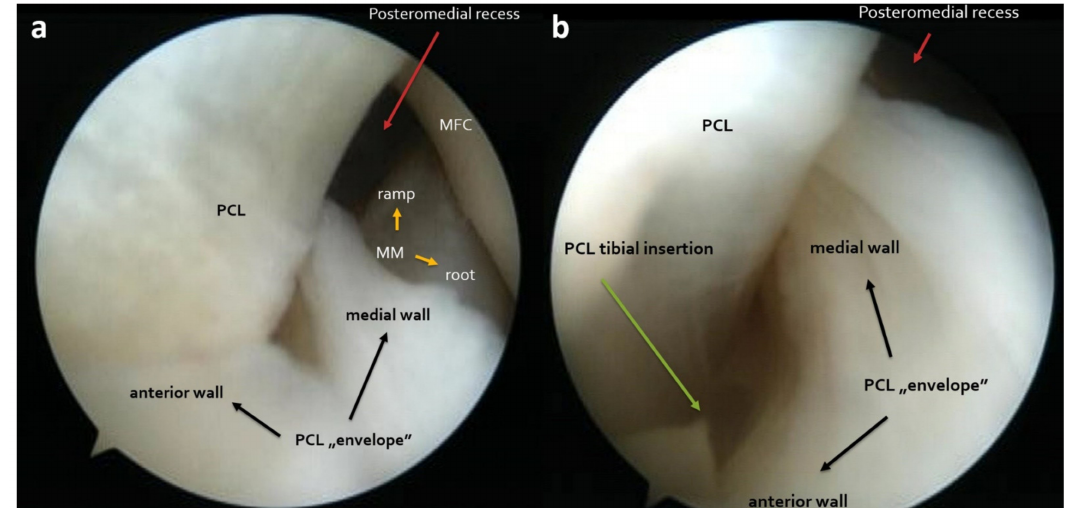
Figure 1. Arthroscopic view from an anterolateral viewing portal in a right knee joint. Trans-notch maneuver. ( a ) The natural soft tissue cuff surrounding the posterior cruciate ligament (PCL) tibial insertion, the so-called PCL “envelope”, can be observed. ( b ) After withdrawing the arthroscope a few millimeters, we visualized the PCL tibial attachment with the surrounding envelope. MFC—medial femoral condyle, MM—medial meniscus.